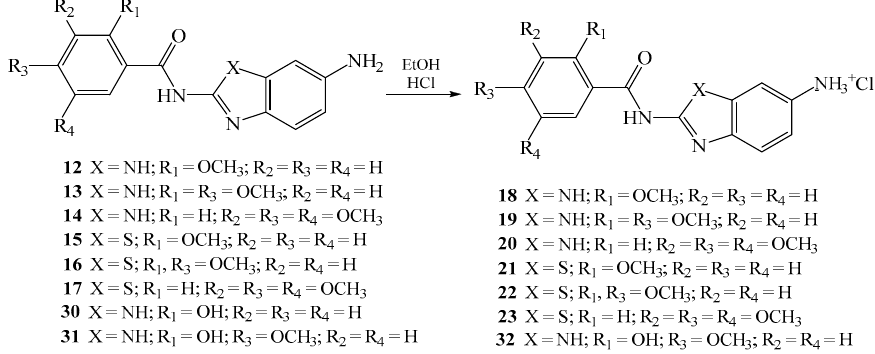
Table 1. IC 50 a values for tested compounds (in µM).